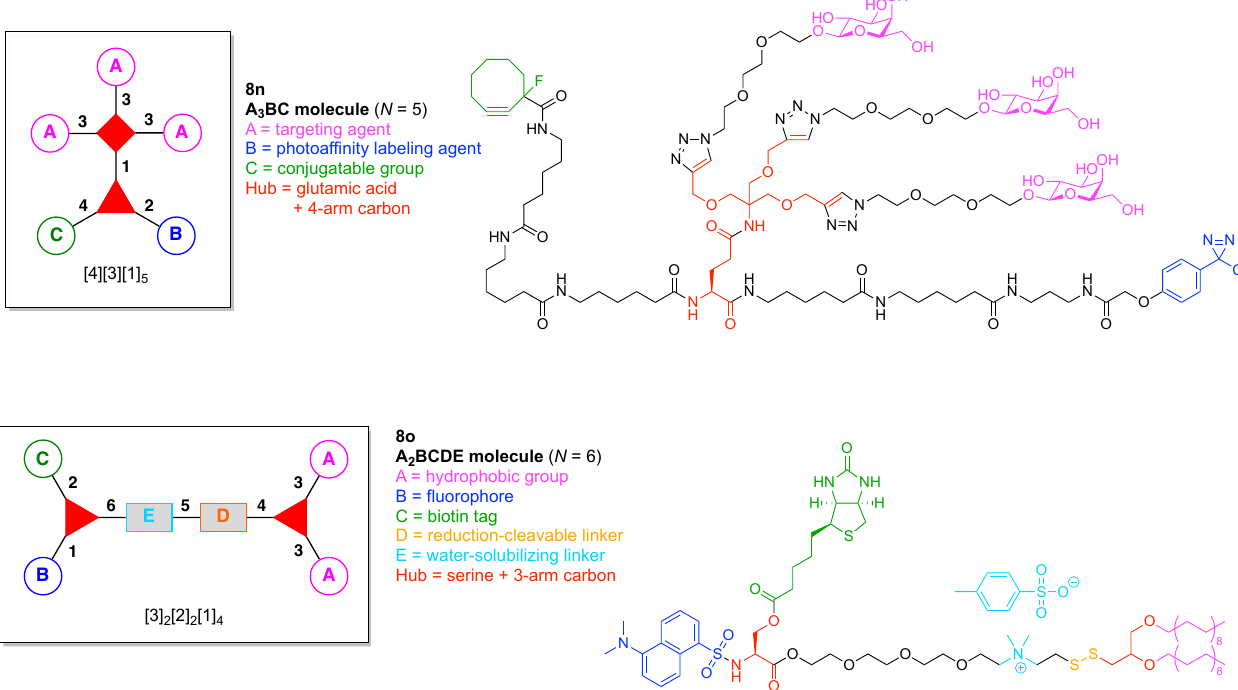
group for late-stage functionalization by strain-promoted [3 + 2]-azide–alkyne cycloaddi-